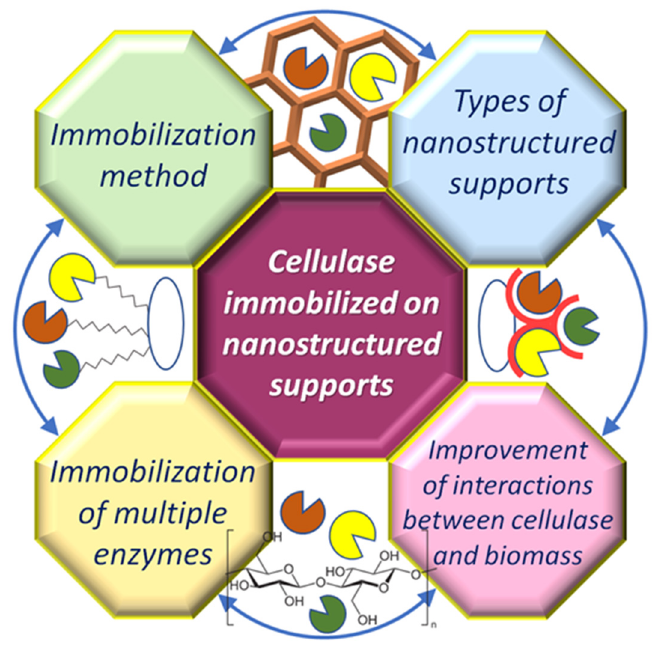
Scheme 1. Schematic representation of the review